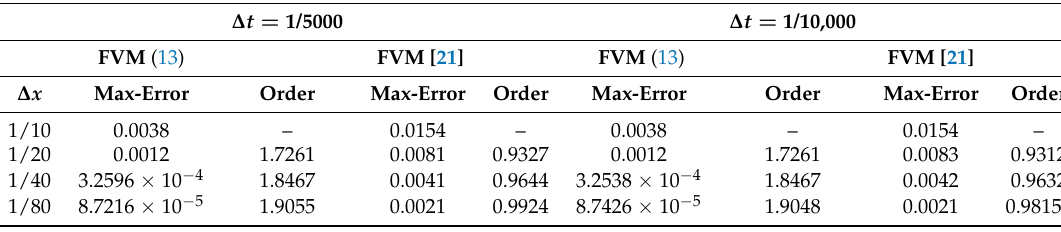
Table 3. Spatial convergence order of new upwind FVM and existing upwind approach of FVM taking k = 0.4, v = 1 in the case of convection